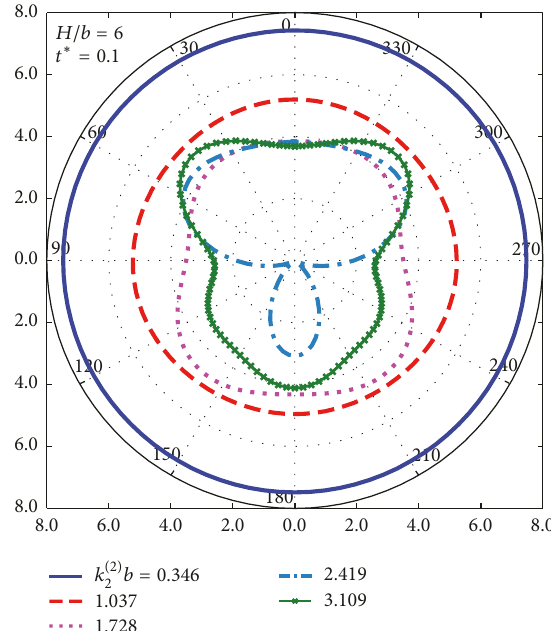
Figure 8: Radial displacement (𝑢 ∗ 𝑟 ) versus polar angle at 𝑟 = 𝑏 for different wave numbers (𝑘 (2) 2 𝑏) for a tunnel in soft soil.